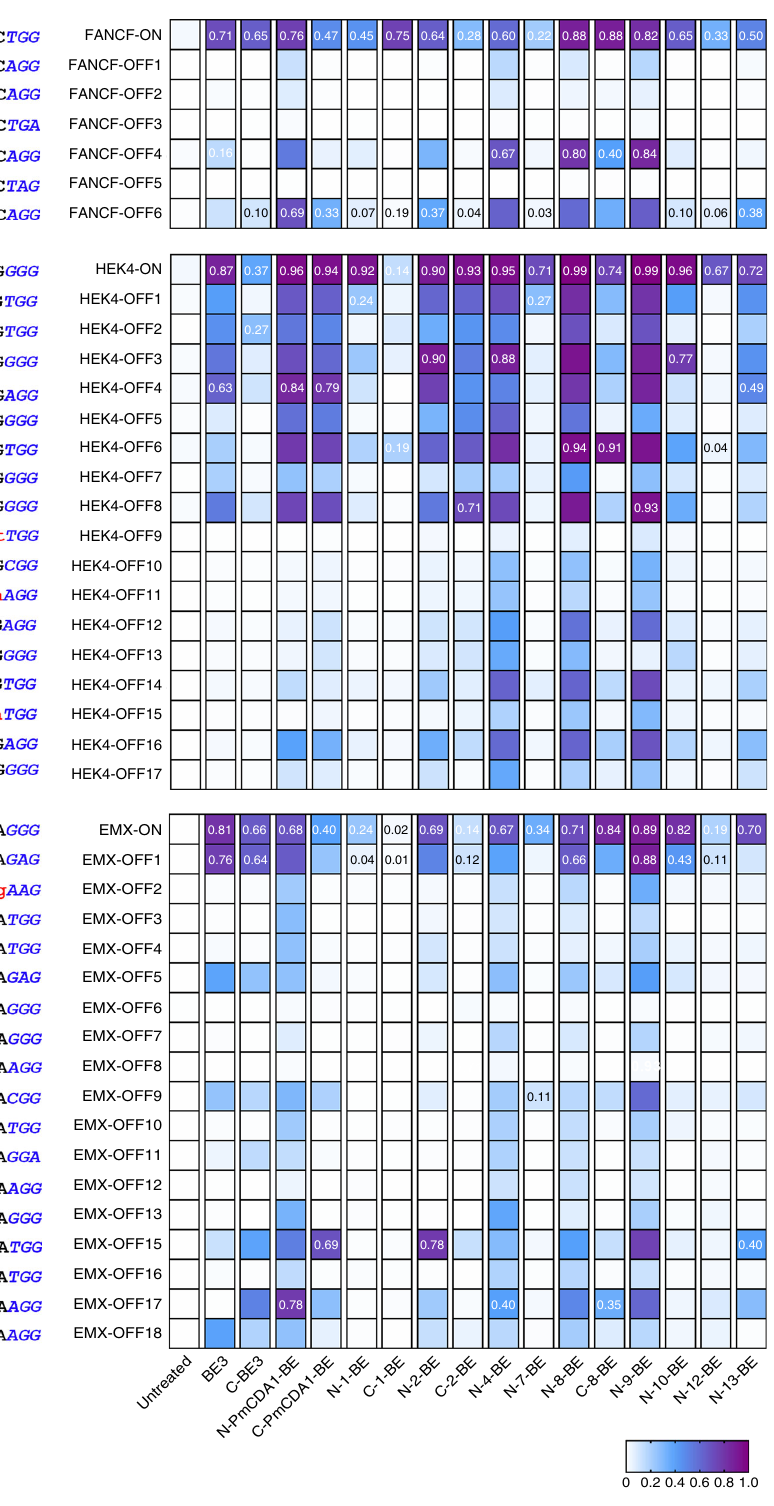
Fig. 6 Off-target activities for sgRNA targeting FANCF, HEK4 and EMX across different functional NT-CBEs and CT-CBEs. Heat map of on-target and corresponding off-target ef fi ciencies of representative functional NT-CBEs and CT-CBEs in HEK293T cells was shown. The highest editing ef fi ciencies of different CBEs for each on-target and off-target site were annotated for comparison. Source data are provided as a Source Data fi